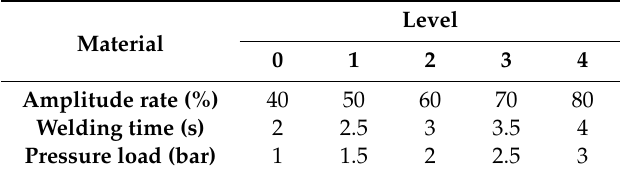
Table 2. Welding parameters and their levels for Taguchi method.